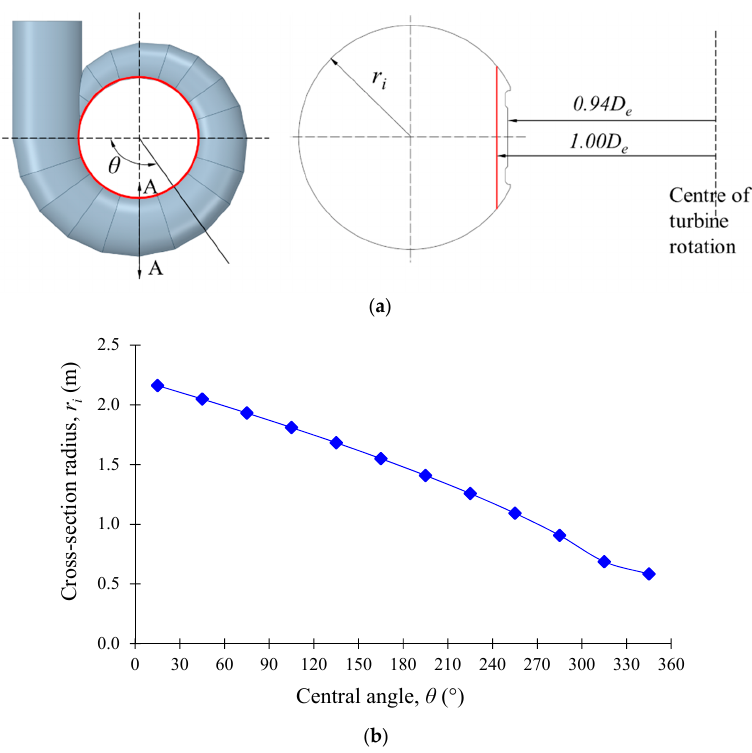
Figure 4. ( a ) Parametric design and ( b ) initial cross-section radius of casing (red line indicates measuring location).